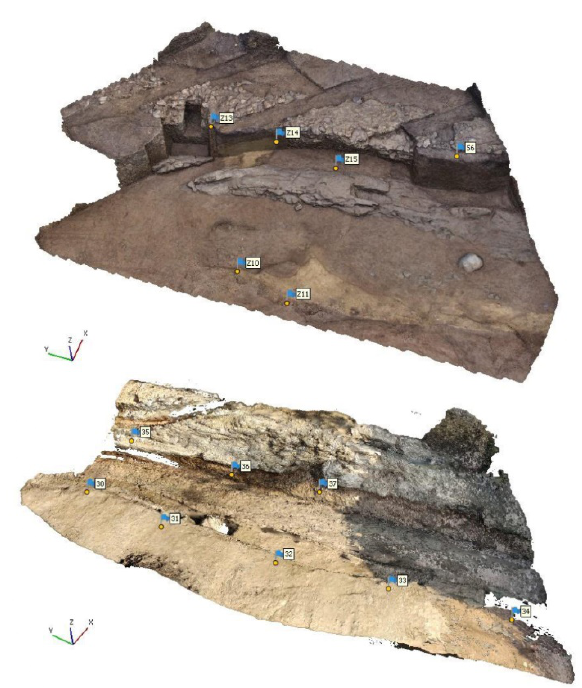
Figure 3 . The two photogrammetric 3D models of the Sette Metri aqueduct. The pictures were taken at two different times during the excavation. Figure 4. The DEM extracted from the 3D model of the Sette